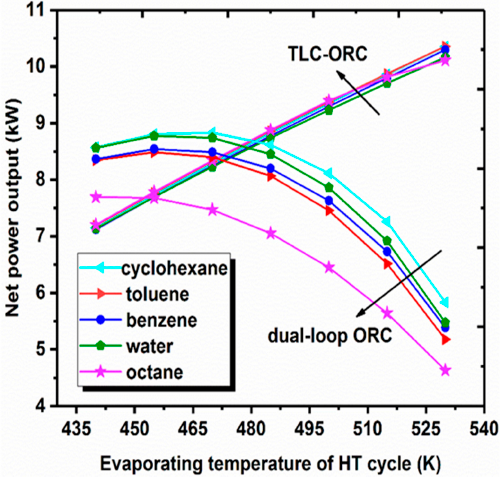
Figure 5. Comparison of net power output between the two systems under different T HT,evap .